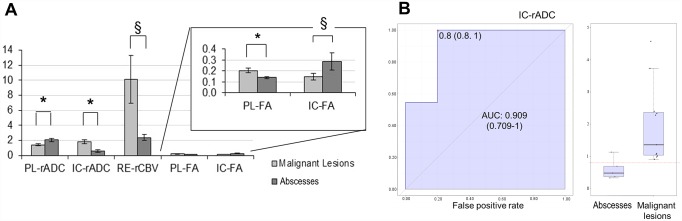
Changes of PL-rADC, IC-rADC, RE-rCBV, PL-FA, and IC-FA between abscesses vs malignant lesions (A) and ROC analysis for IC-rADC (B).Bar graphs show mean values ± standard error (SEM; nMalignant Lesions = 9; nAbscesses = 5). * indicates statistically significant differences as assessed by Mann-Withney U test (95% confidence level). § indicates p<0.100. The insert shows an enlarged view of the bar graph. The value of the area under curve (AUC) with the 95% confidence interval, the optimal threshold of IC-rADC, and the corresponding sensitivity and specificity are shown in the panel B.